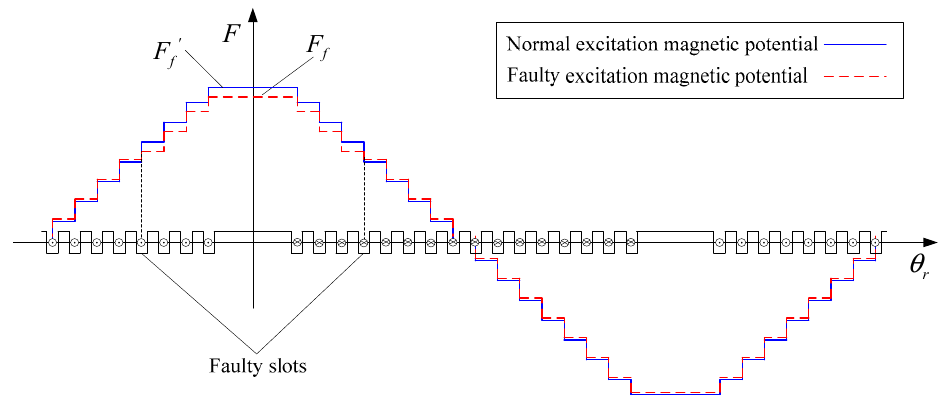
Figure 2. Waveform of excitation magneto motive force. F f is the excitation magneto motive force in a stepped wave after a turn-to-turn short circuit; F f ’ is the excitation magneto motive force of the stepped wave when the winding is normal.